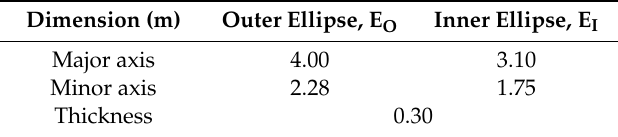
Figure 2. Schematic illustration of the crescent-shaped plate. Table 1. Dimensions of each component of the crescent-shaped plate.